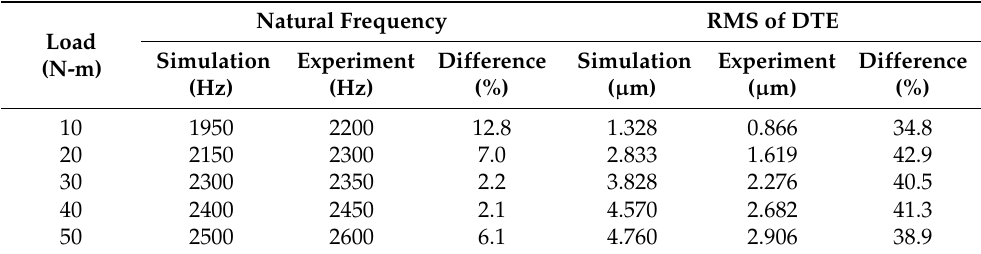
Table 2. Dynamic analysis and experimental